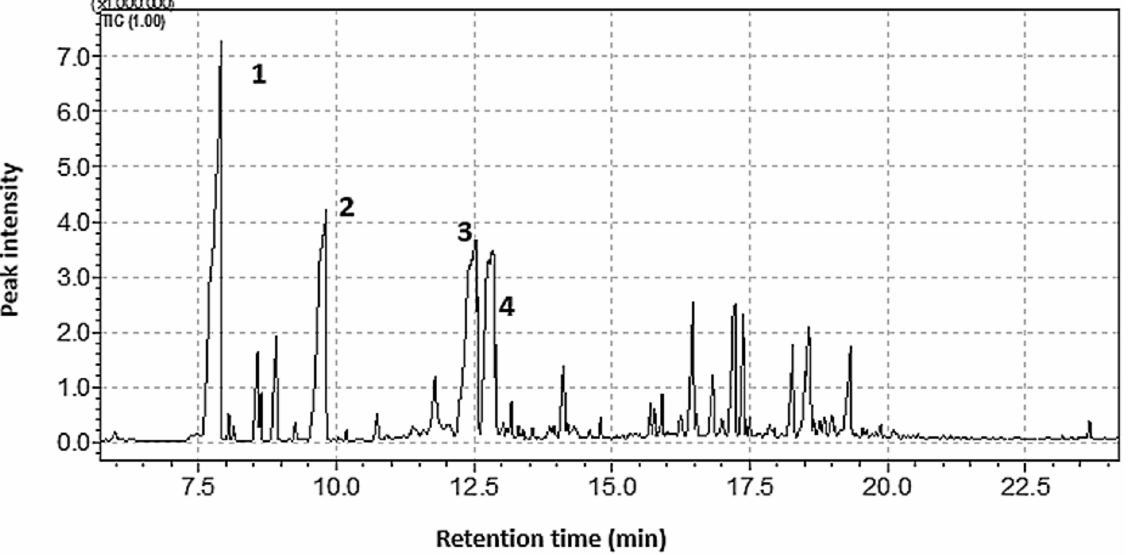
Figure 1. A chromatogram of the 20-min headspace single-drop micro-extraction (SDME) extract of the commercial oil with 2 µ L heptadecane and analysed using gas chromatography with flame ionisation